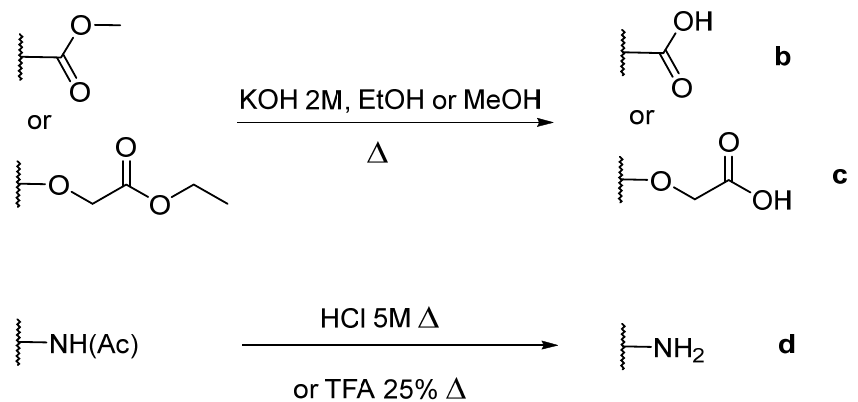
Figure 1. Deprotection of carboxylic acid and amine functions.